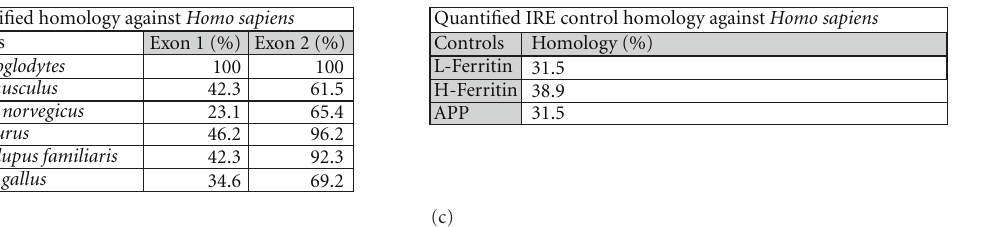
Figure 1: The 5 (cid:2) untranslated region (5 (cid:2) UTR) of the Parkinson’s disease alpha-synuclein ( SNCA ) transcript is homologous to the iron- responsive element (IRE) in H-ferritin mRNA. (a) Top panel : The SNCA 5 (cid:2) UTR is encoded by exon-1 and exon-2 of the SNCA gene, which can be alternatively spliced to generate either a shorter exon-1/-2 transcript or a longer exon-1 (cid:2) -2 transcript [58]. Bottom panel: evolutionary alignment of the SNCA 5 (cid:2) UTR relative to the human sequence and the CAGUGN loop/splice site sequences [33]. We quantified the homology across the SNCA splice junction in the 5 (cid:2) untranslated region. (b) RNA/FOLD computer program predictions of RNA stem loops from SNCA 5 (cid:2) UTR sequences ( Δ G = 53 kcal/mol). The human SNCA stem loop resembles the classical IRE RNA stem loop (5 (cid:2) CAGUGN3’ loop motif) that controls iron-dependent L- and H-ferritin translation and transferrin receptor (TfR) mRNA stability. Stem loops from the 5 (cid:2) UTRs of several species were predicted to be folded, as described in the Materials and Methods section, and the pseudotriloop AGU is depicted in red lettering at the apex of the H-ferritin IRE [59] where the analogous AGA from the APP IRE is depicted [50]. The human SNCA mRNA exhibited an AGU triloop, whereas, in lower vertebrates, this AGU motif was located in the stem regions of these transcripts. Shown are the arrangement of splice sites and 5 (cid:2) UTR structures in the SNCA , SNCB , SNCG mRNAs. Tabulated: the first table shows the homology between the IRE-like domains in each exon of the human alpha-synuclein compared to its counterparts in di ff erent mammalian species. The second table shows the homology between the 5 (cid:2) untranslated regions of SNCA with the APP and ferritin L- and H-chains. This data underscored our identification of cotranslational repression of APP and alpha-synuclein by small molecules, such as phenserine and